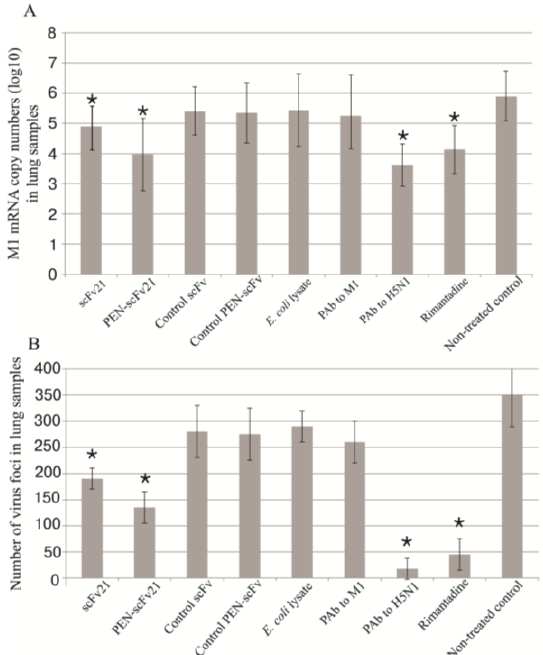
Figure 5. Viral loads in mouse lungs at 96 h post infection with adamantane sensitive A/chicken/Thailand/NP-172/2006 (H5N1) in ( A ) M1 mRNA copy numbers (log 10 ) and ( B